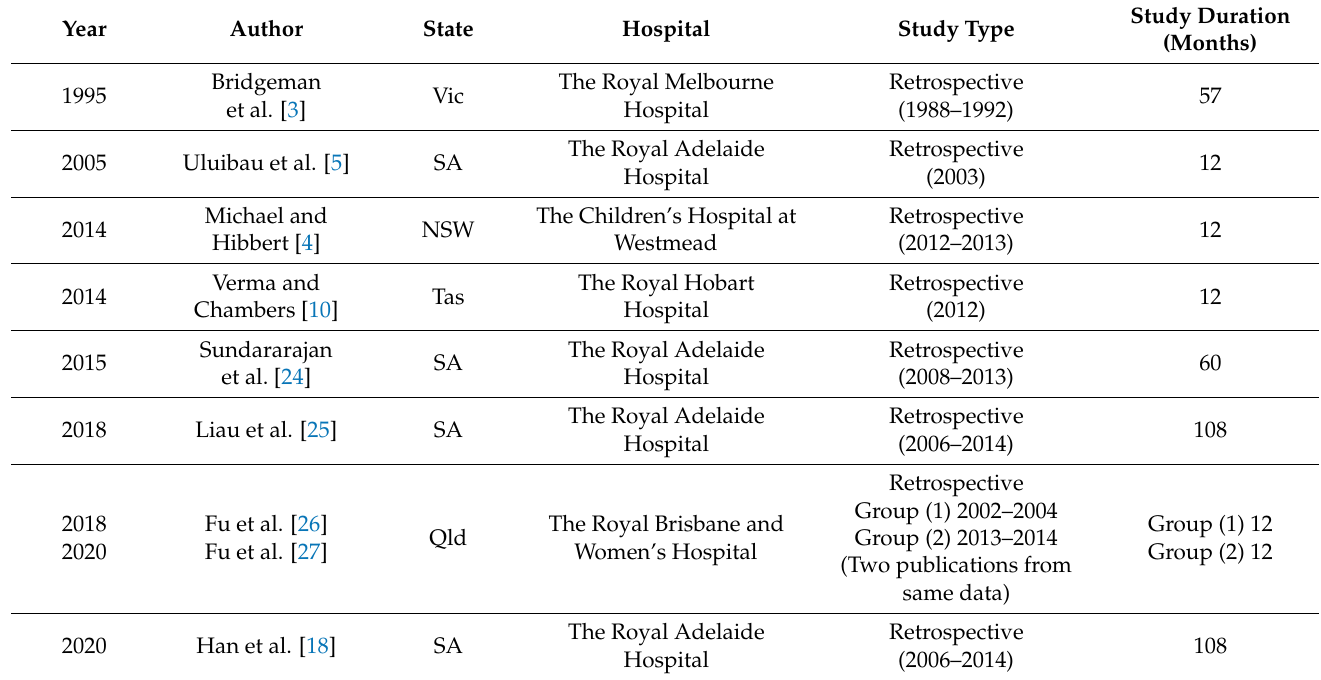
Table 1. Characteristics of the included studies.